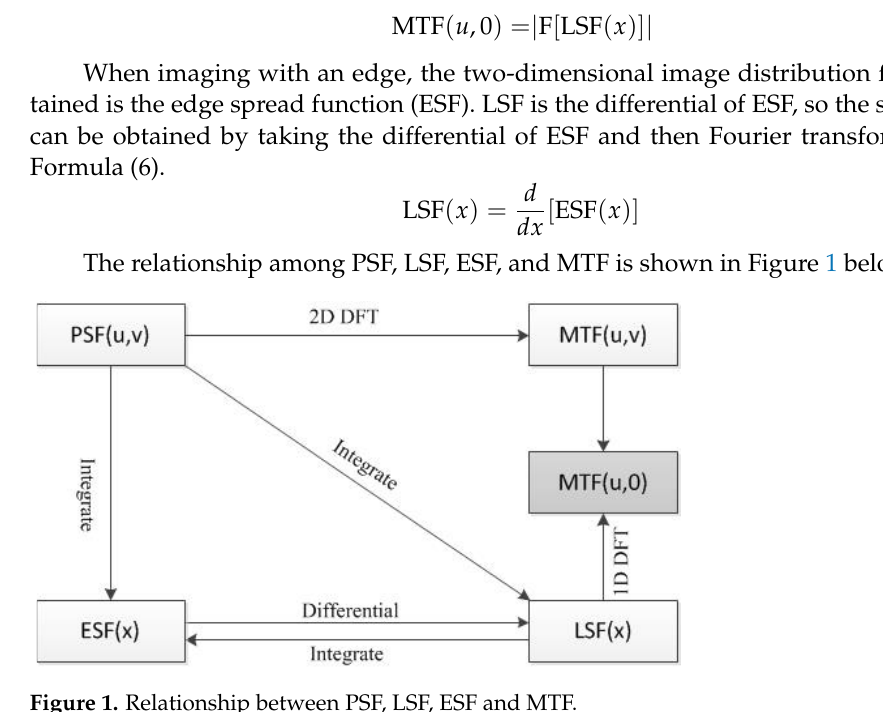
Figure 1. Relationship between PSF, LSF, ESF and MTF.